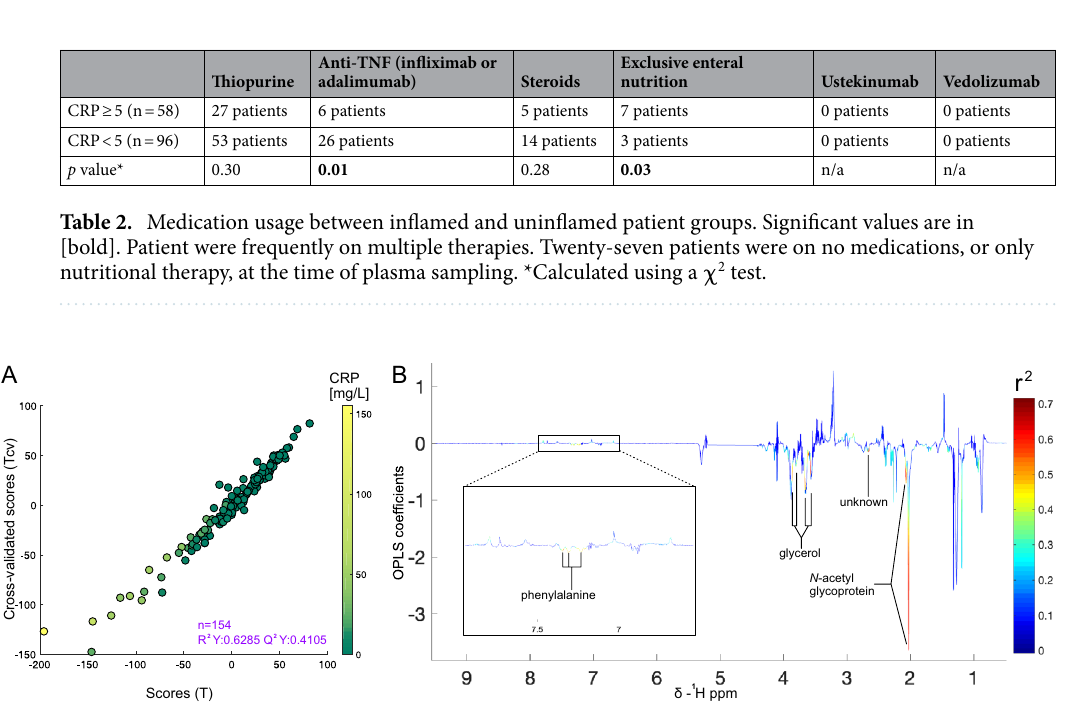
Figure 2. CRP prediction and spectra deconvolution. ( A ) OPLS scores plot. Each point represents one patient spectrum, colour-coded according to CRP levels. Strong correlation between T and Tcv indicates a robust model. ( B ) Loadings plot; colour-scale indicates the correlation magnitude of metabolites with the model scores (r 2